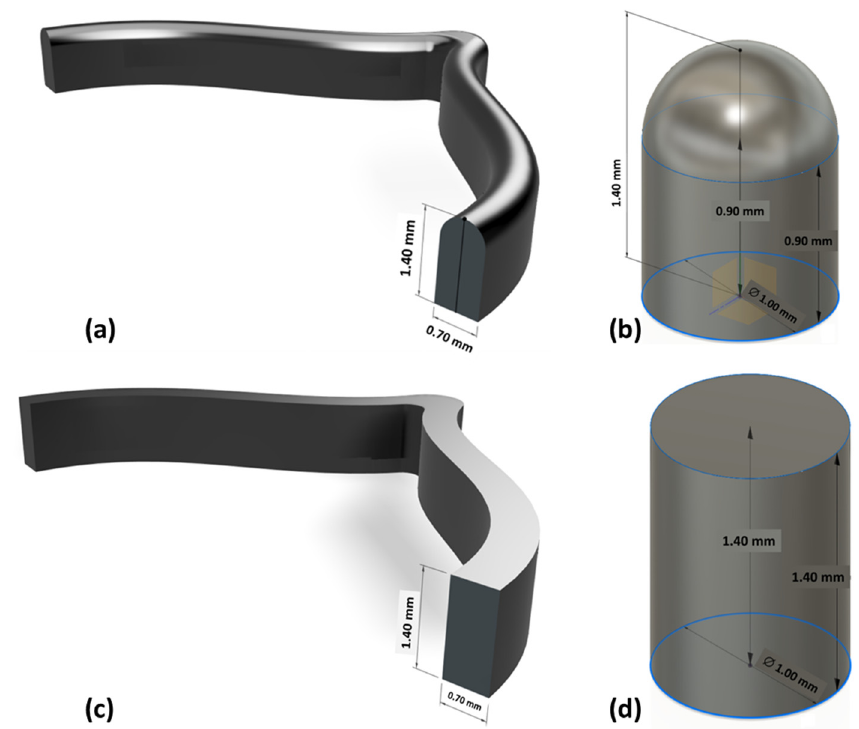
Figure 3. Finishing geometry and dimensions of the lines and dots engraved in the 3D steel plates: ( a ) line with a round finishing, ( b ) dot with a round finishing, ( c ) line with a straight finishing, and ( d ) dot with a straight finishing.